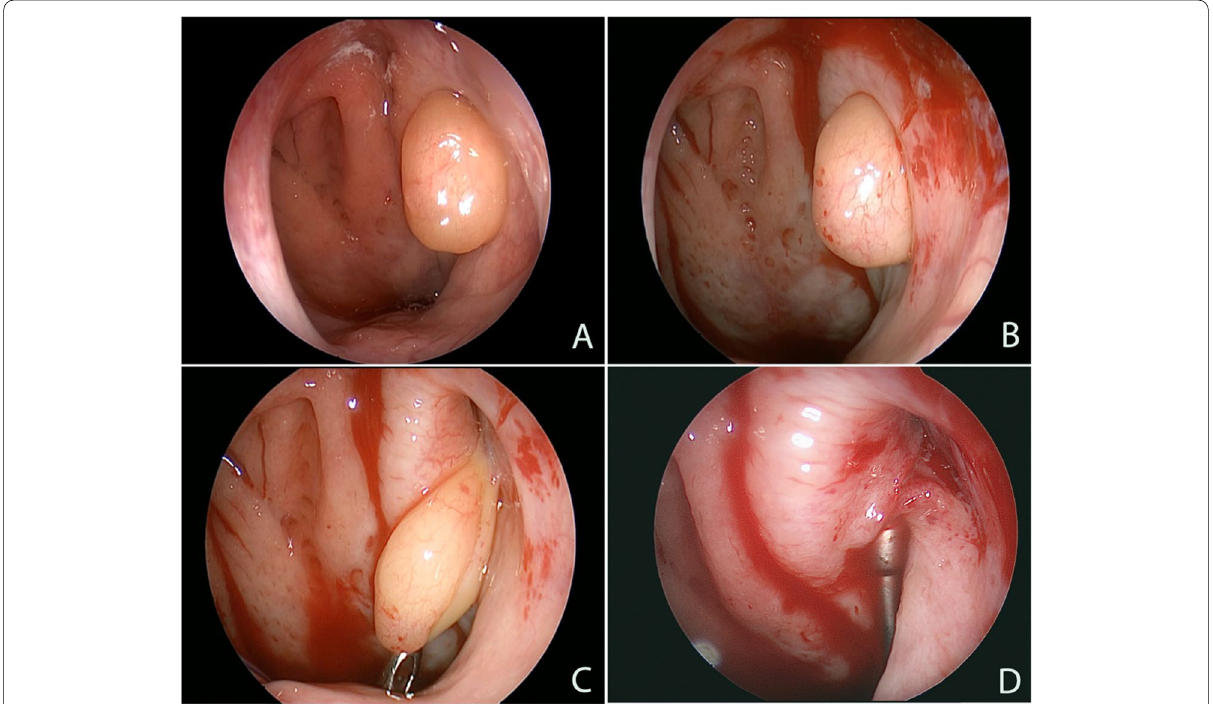
Fig. 1 A Transnasal intraoperative view of a polyp‑like lesion protruding through the left ET orifice measuring (1 after removing the bulky tail of the left inferior turbinate to improve exposure. C Grabbing the polyp during surgery visualizing its origin from inside the lumen of the ET. D After complete excision of the polyp and the ET orifice looks widely